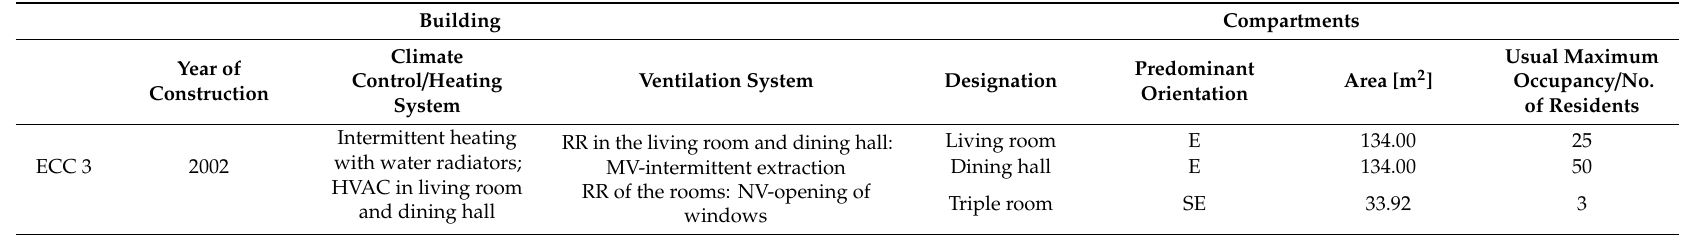
Table 3. Covilh ã : physical characterization of the studied